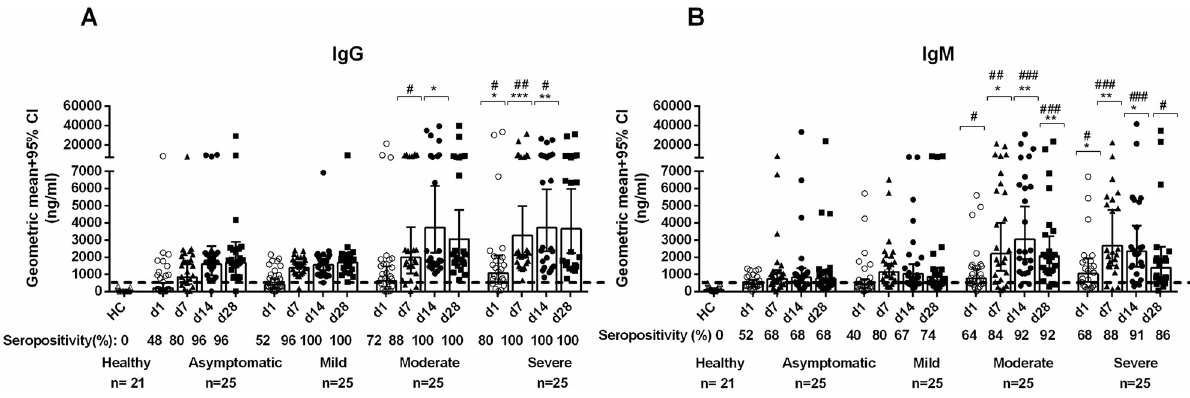
Fig 4. SARS-CoV-2 specific antibody responses in COVID-19 cases and controls. The SARS-COV-2 RBD specific serum (A) IgG and (B) IgM antibody concentrations in healthy individuals (n = 21) and asymptomatic (n = 25), mild (n = 25), moderate (n = 25) and severe (n = 25) COVID-19 patients on study day 1, day 7, day 14 and day 28. Bars represent geometric mean concentration with 95% CI and the dotted line indicates the cut-off (500 ng/ml) limit of seropositivity. Compared to healthy controls, all patients had significantly higher (P < 0.0001) IgM and IgG antibodies at all time points. Asterisks ( � ) represent significant differences between mild patients vs. moderate and severe patients and hashes (#) represent significant differences between asymptomatic patients vs. moderate and severe patients on different days. Statistical analysis was performed using the Mann- Whitney test. � /# P < 0.05, �� /## P < 0.01, ��� /### P < 0.001.